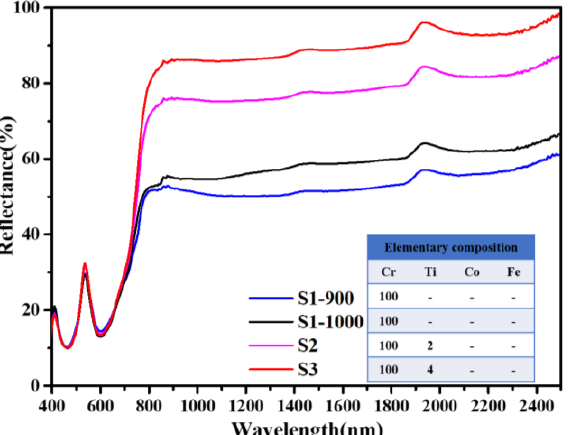
Figure 5. Influence of calcination temperature and Ti doping on diffuse reflectance spectra of Cr 2 O 3 samples.